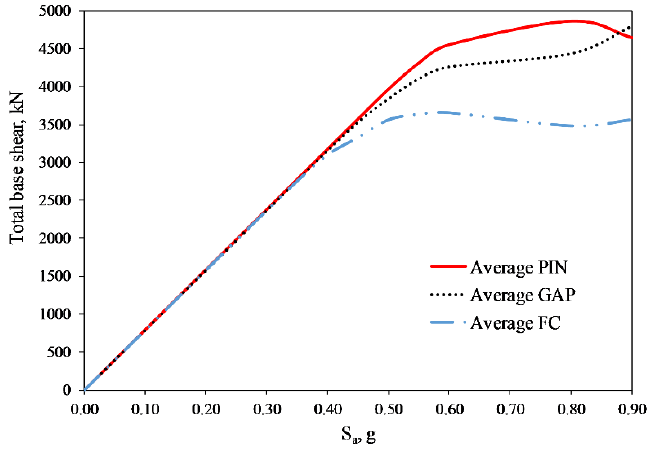
Figure 14. Total base shear.